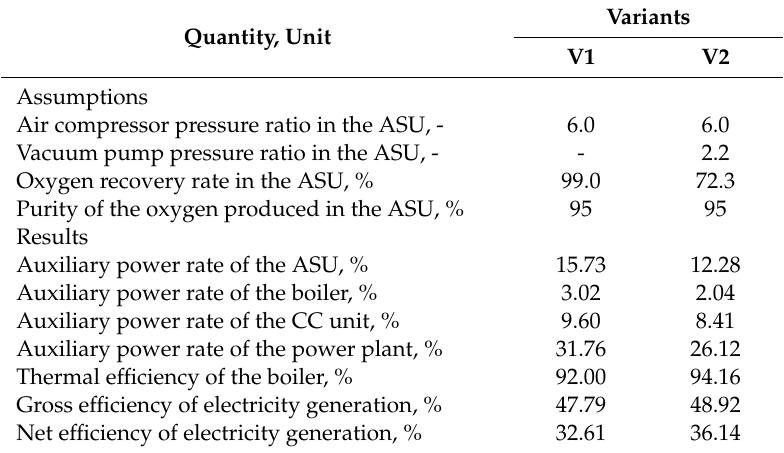
Table 6. Thermodynamic analysis results (variants V1 and